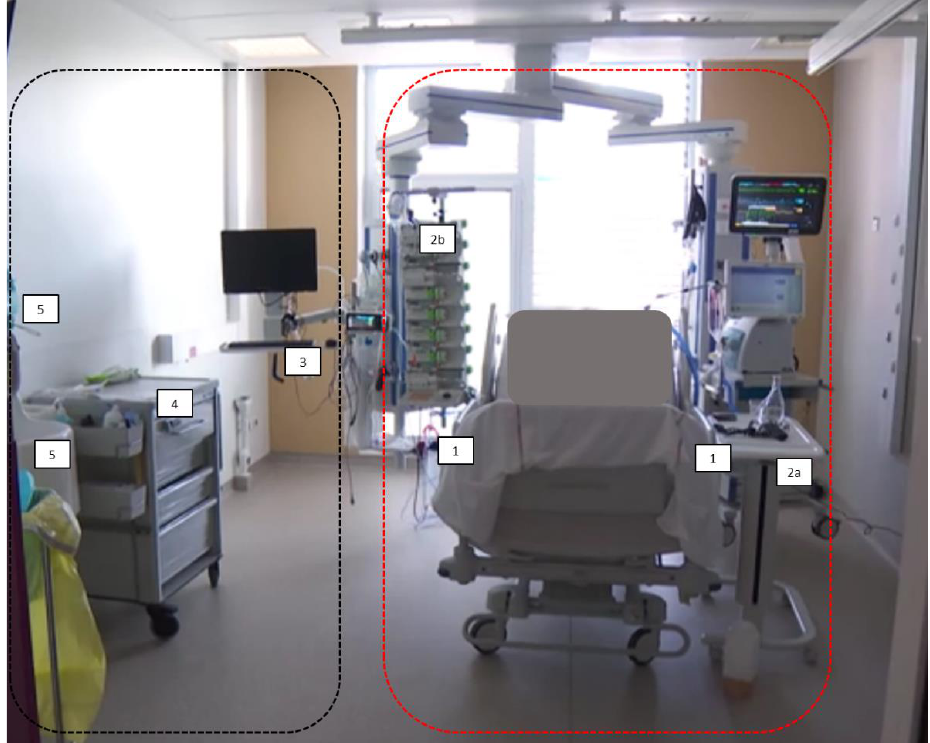
Figure 1. In an ICU room, sampling sites inside the red dashed line belong to the area close to patient (1, 2a in ICU#1, 2b in ICU#2), while sampling sites inside the black dashed line are in the zone distant from patient (3, 4, and 5). 1: foot-side bedrails; 2a: bedside table; 2b: room-dedicated stethoscope; 3: computer keyboard and mouse; 4: worktop/nurse cart; 5: washbasin and levers of hydro-alcoholic solution and soap